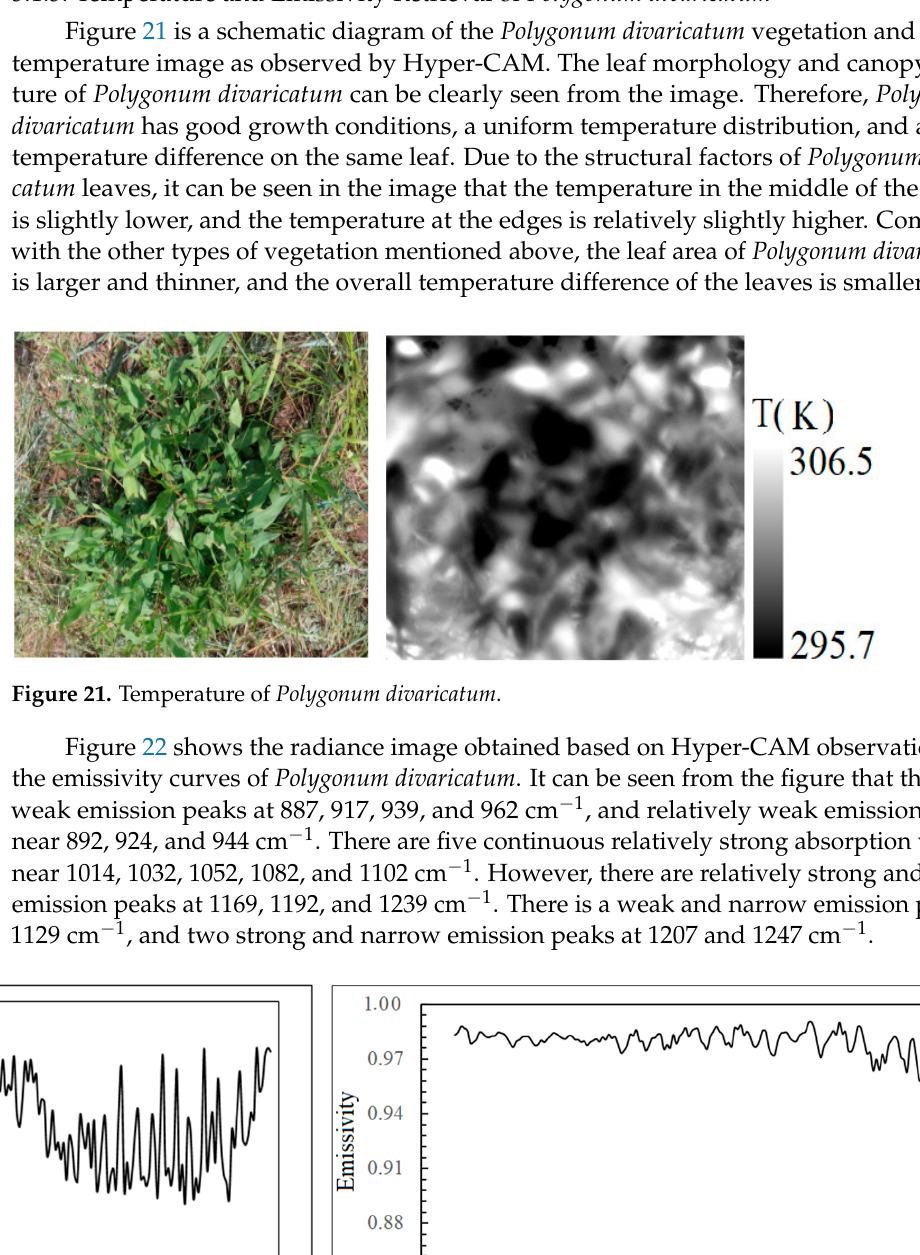
Figure 22. Results of emissivity retrieval and the down-welling radiance. ( a ) is the down-welling radiance retrieved from the gold-plate, and ( b ) the emissivity of Polygonum divaricatum.